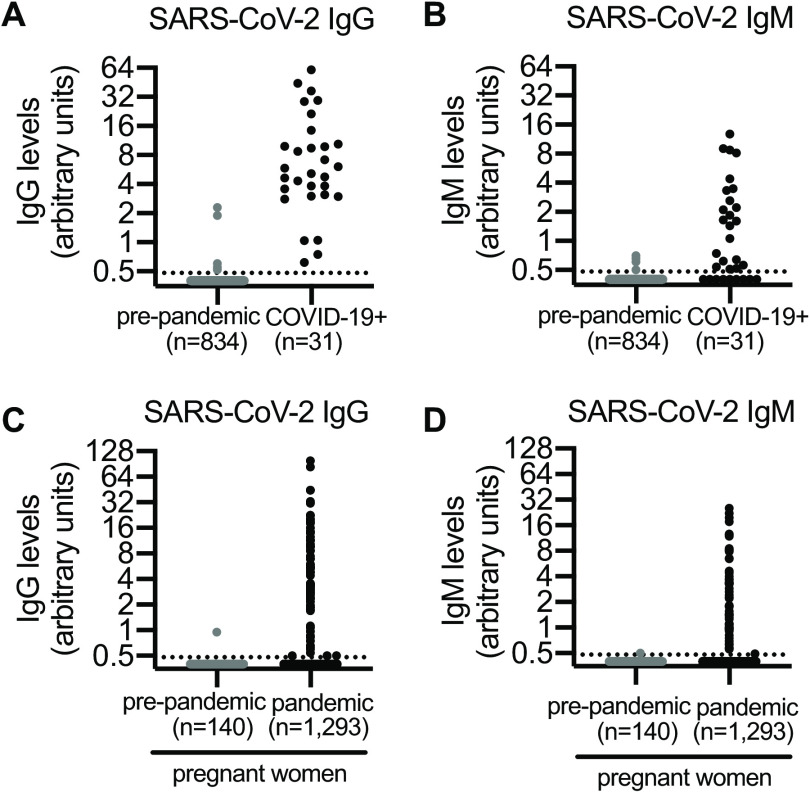
Serum SARS-CoV-2 antibody levels in COVID-19 pandemic and pre-pandemic individuals.(A-B) Relative levels of SARS-CoV-2 IgG (A) and IgM (A) in serum collected before the COVID-19 pandemic (n = 834) and serum collected from COVID-19 recovered donors (n = 31). (C-D) Relative levels of SARS-CoV-2 IgG (C) and IgM (D) in serum collected from pregnant women from 2009-2012 (n = 140) and from April 4-June 3, 2020 (n = 1,293). Dashed lines indicate 0.48 arbitrary units, which was used to distinguish positive versus negative samples (see Methods). Serum samples that were below the cutoff for seropositivity were assigned an antibody level of 0.40 arbitrary units.